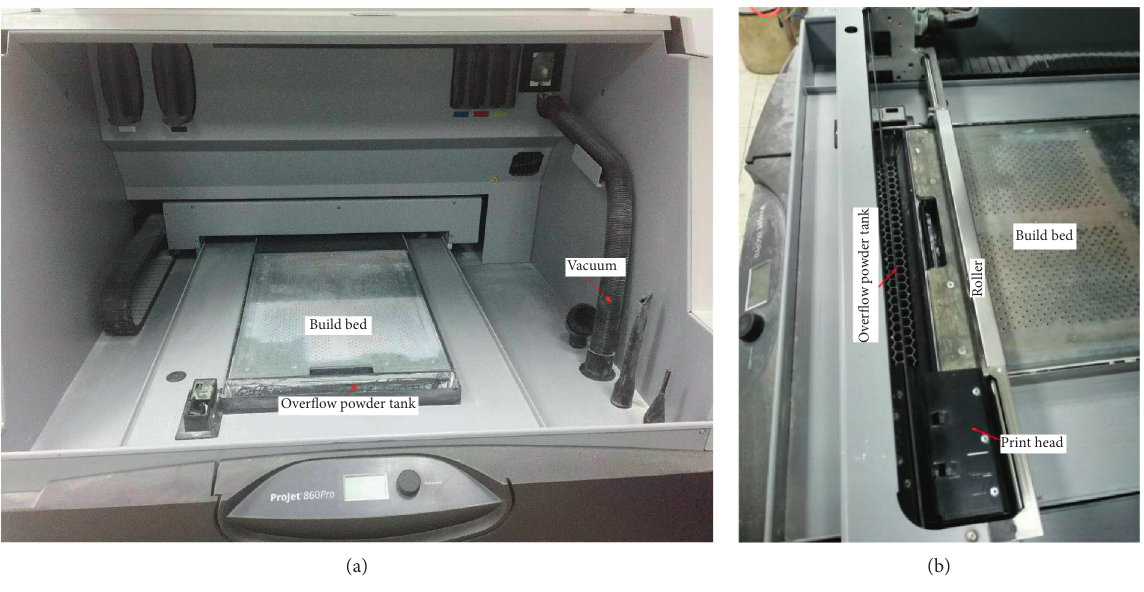
Figure 1: ProJet 860 3D printer. (a) Front view. (b) Close-up view.